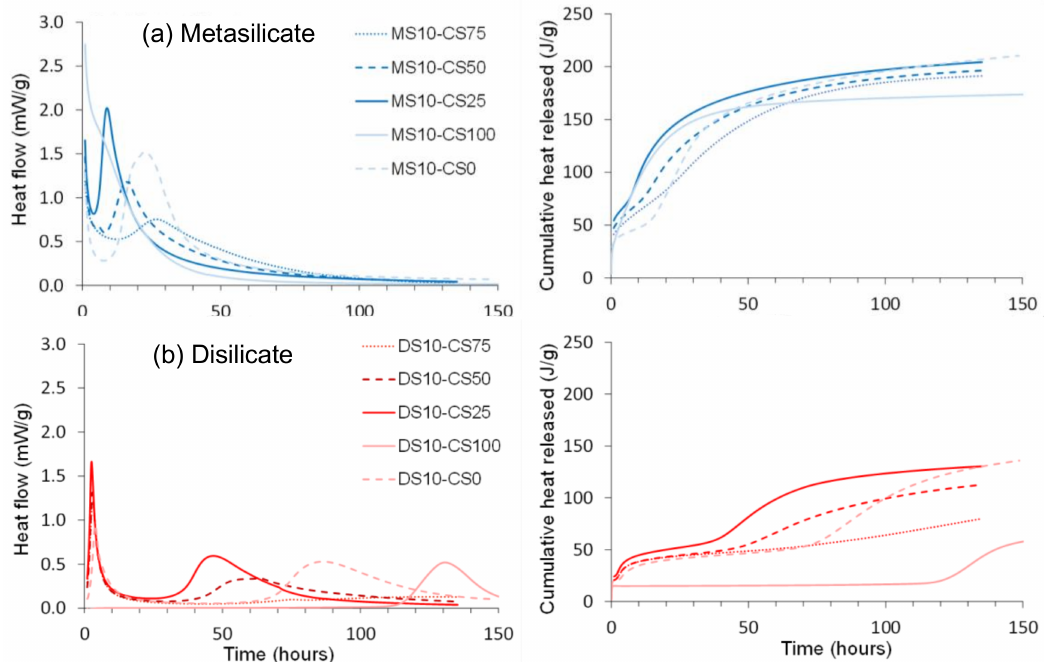
Figure 6. Normalized heat flow and cumulative heat released of ( a ) disilicate (DS) and ( b ) metasilicate (MS) based